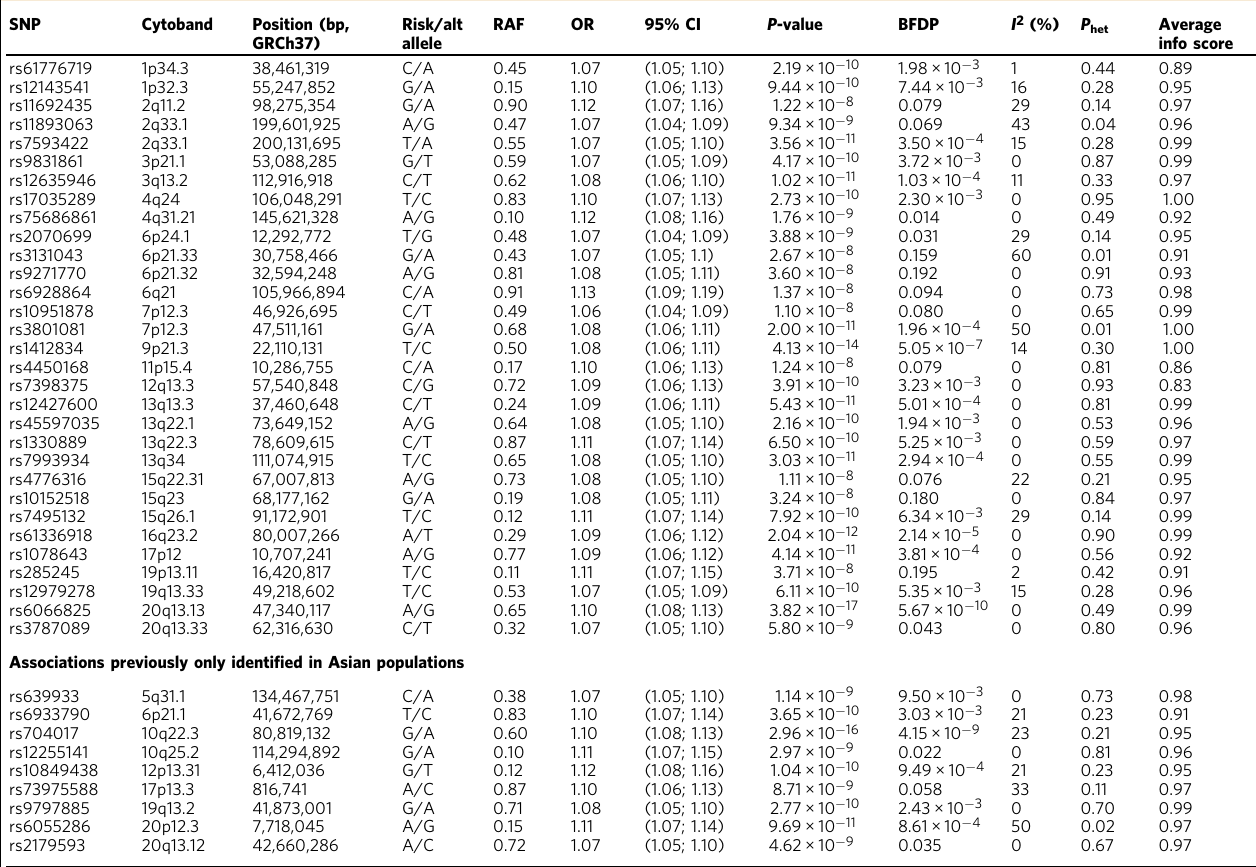
Table 1 Summary results for the new colorectal cancer risk loci in Europeans SNP Cytoband Position (bp, Risk/alt GRCh37)